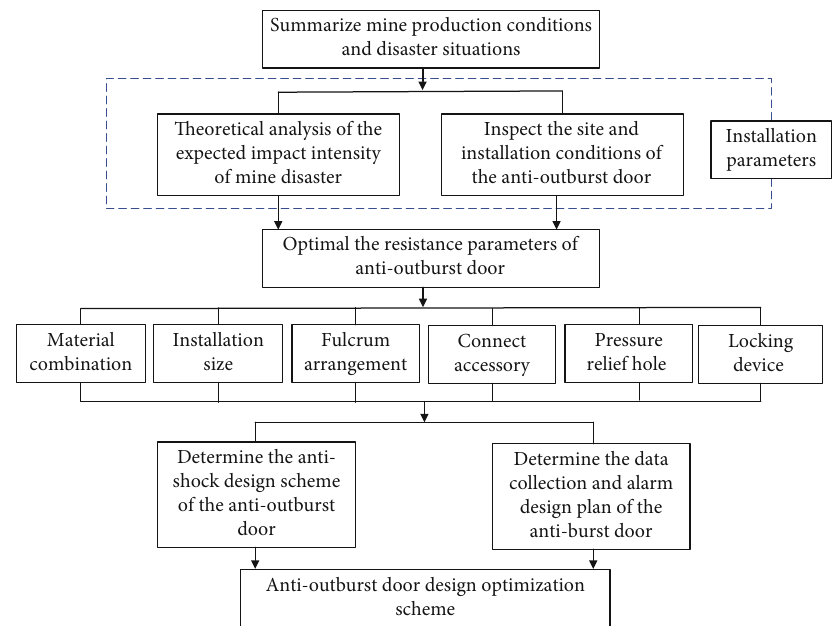
Figure 8: The overall design idea of the antioutburst